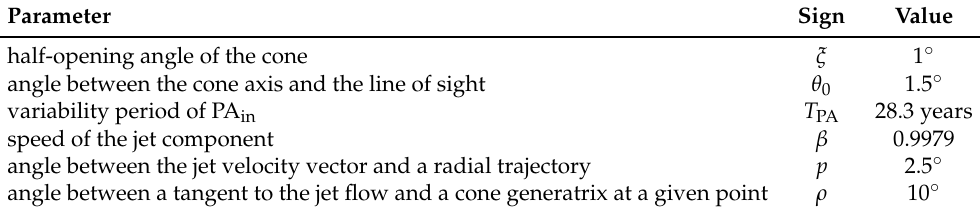
Table 2. Geometric and kinematic parameters derived for the blazar OJ 287 helical jet on parsec scales. Parameter Sign Value half-opening angle of the cone ξ 1 ◦ angle between the cone axis and the line of sight θ 0 1.5 ◦ variability period of PA in T PA 28.3 years speed of the jet component β 0.9979 angle between the jet velocity vector and a radial trajectory p 2.5 ◦ angle between a tangent to the jet flow and a cone generatrix at a given point ρ 10